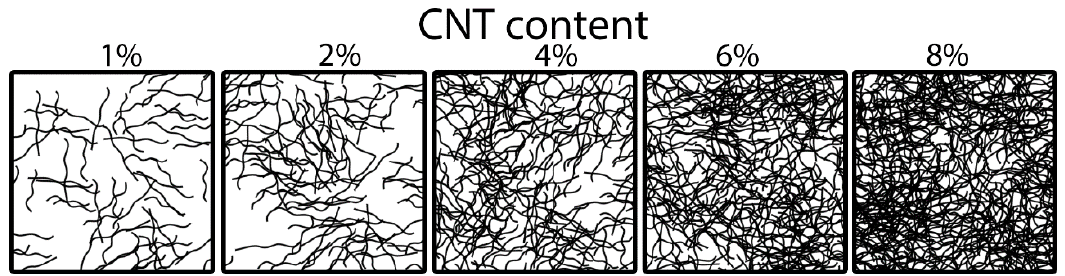
Figure 10. Schematic representation of CNT distribution in the SIBS matrices of different nanofiller concentrations.